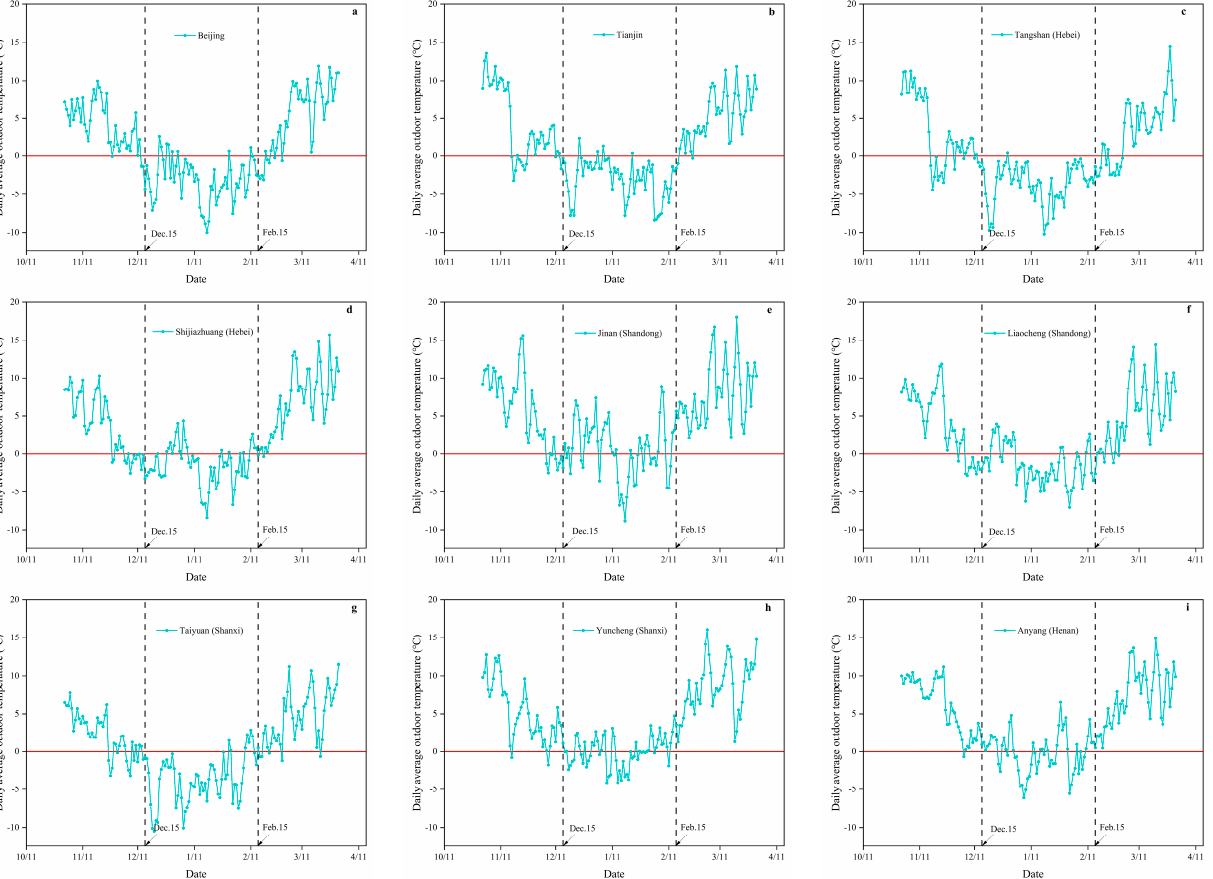
Figure 2. Annual average daily outdoor temperature in winter in different cities of the northern region ( a ). Beijing; ( b ). Tianjin; ( c ). Tangshan; ( d ). Shijiazhuang (Hebei); ( e ). Jinnan (Shandong); ( f ). Liaocheng (Shandong); ( g ). Taiyuan (Shanxi); ( h ). Yuncheng (Shanxi); ( i ). Anyang (Henan).